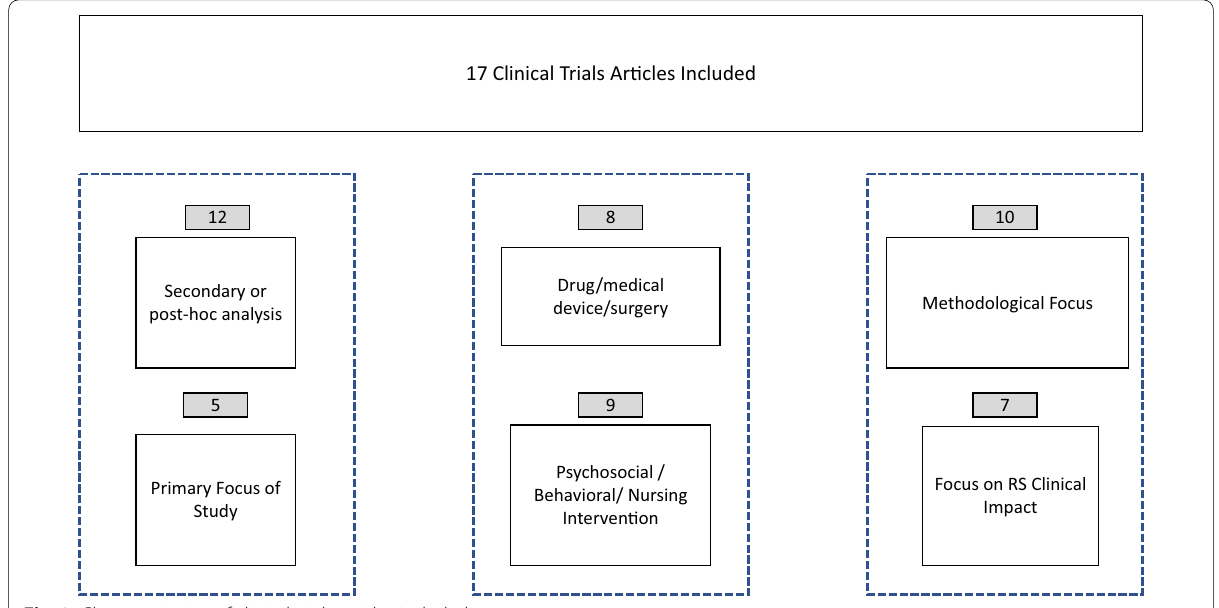
Fig. 2 Characterization of clinical‑trials articles